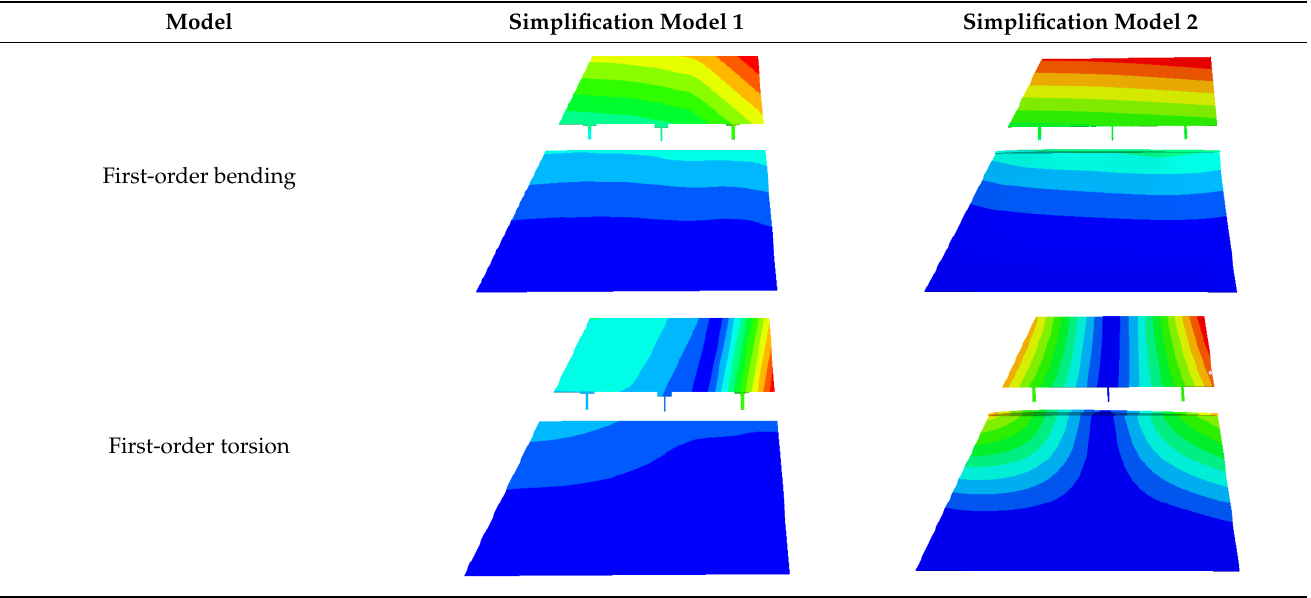
Table 6. Vibrational modes of the two FEM simplified models.